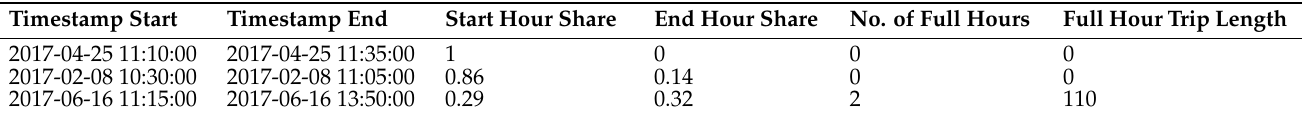
Table A2. Exemplary trip timestamps and respective conversions to shares of end and starting hours as well as number and trip length of full hours in the trip. The first row shows a single-hour trip, the second row a single-hour trip starting in a different hour than ending and the third row a multiple-hour trip.